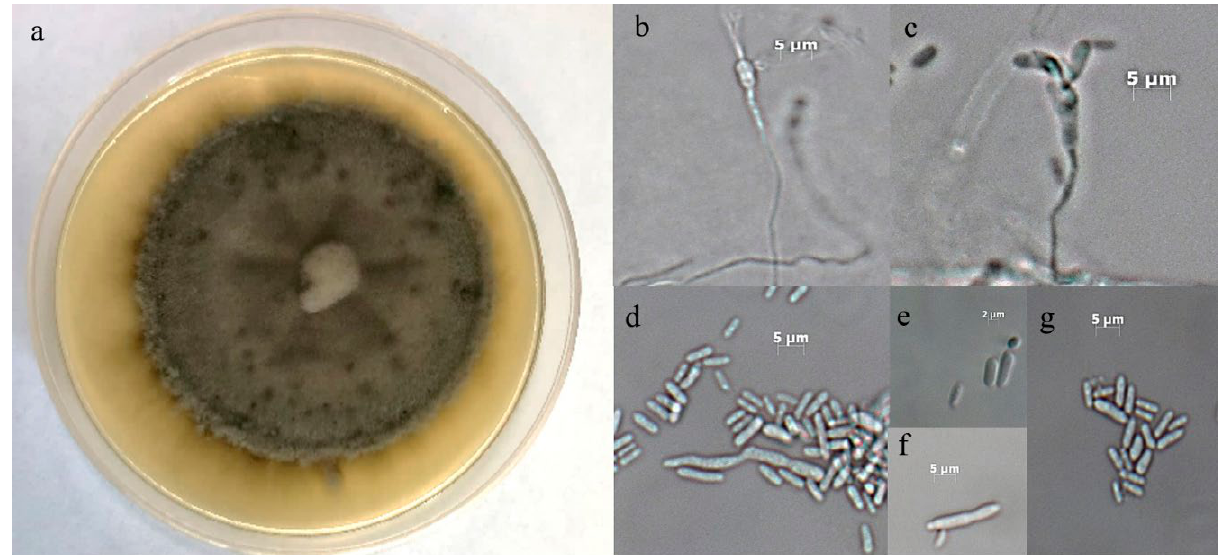
Figure 2. Macroscopic and microscopic features of Cadophora luteo-olivacea isolated from declining young grapevines cv. Muller-Thurgau in Sicily. a, colony growing on MEA. b, c and d, conidiophores of C. luteo-olivacea . d and e, short terminal or lateral phialides. g, hyaline conidia .